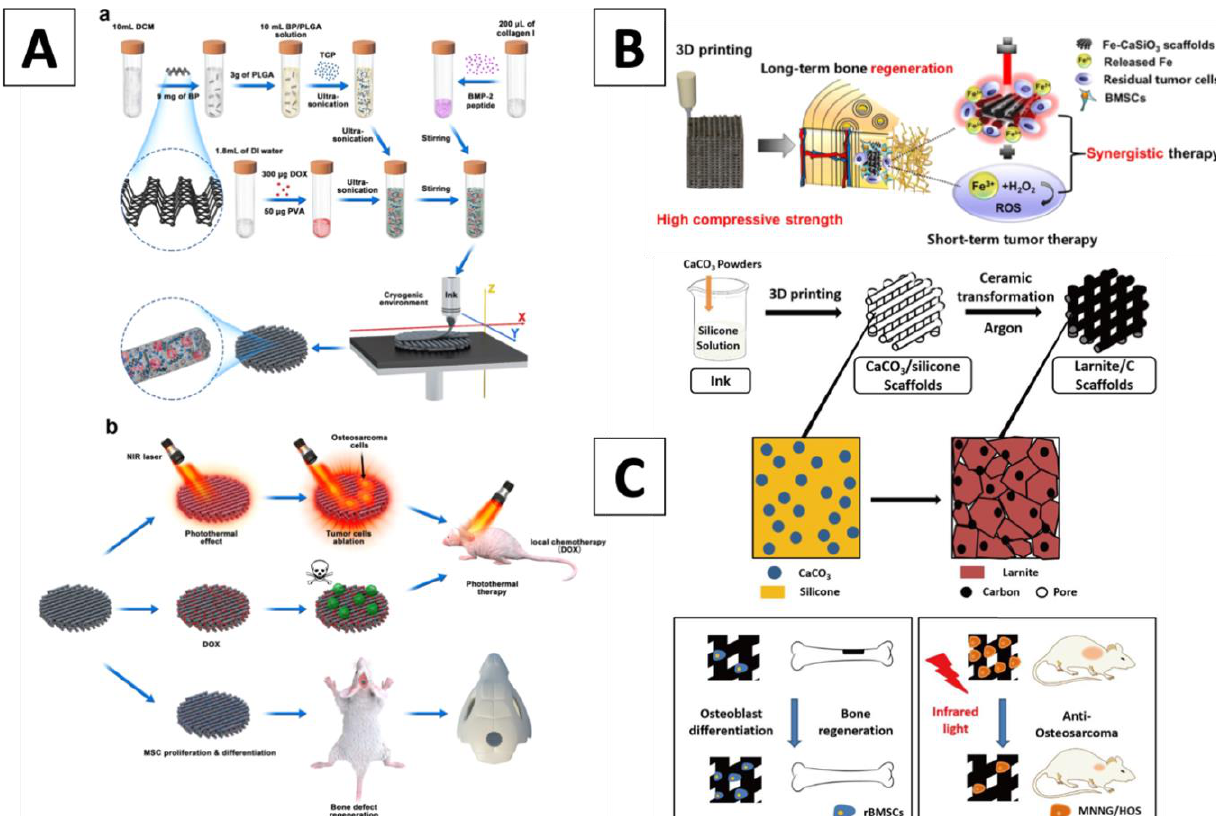
Figure 2. ( A ) Illustration of the cryogenic 3D printing process for the generation of multi-functional scaffolds along with their biomedical application; (a) Synthesis process and 3D printing of multi-functional scaffolds; (b) Process of tumor tissue ablation in mice by mean of photothermal therapy and localized chemotherapy, as well as total regeneration of cranial bone defects (Wang 2020); ( B ) Illustration of the fabrication of Fe-CaSiO 3 scaffolds and their biomedical application for long-term bone regeneration by offering a synergistic therapy with short-term tumor therapy (Ma 2018); ( C ) Illustration for the fabrication process of the larnite/C scaffolds and their biomedical applications (Fu 2020).